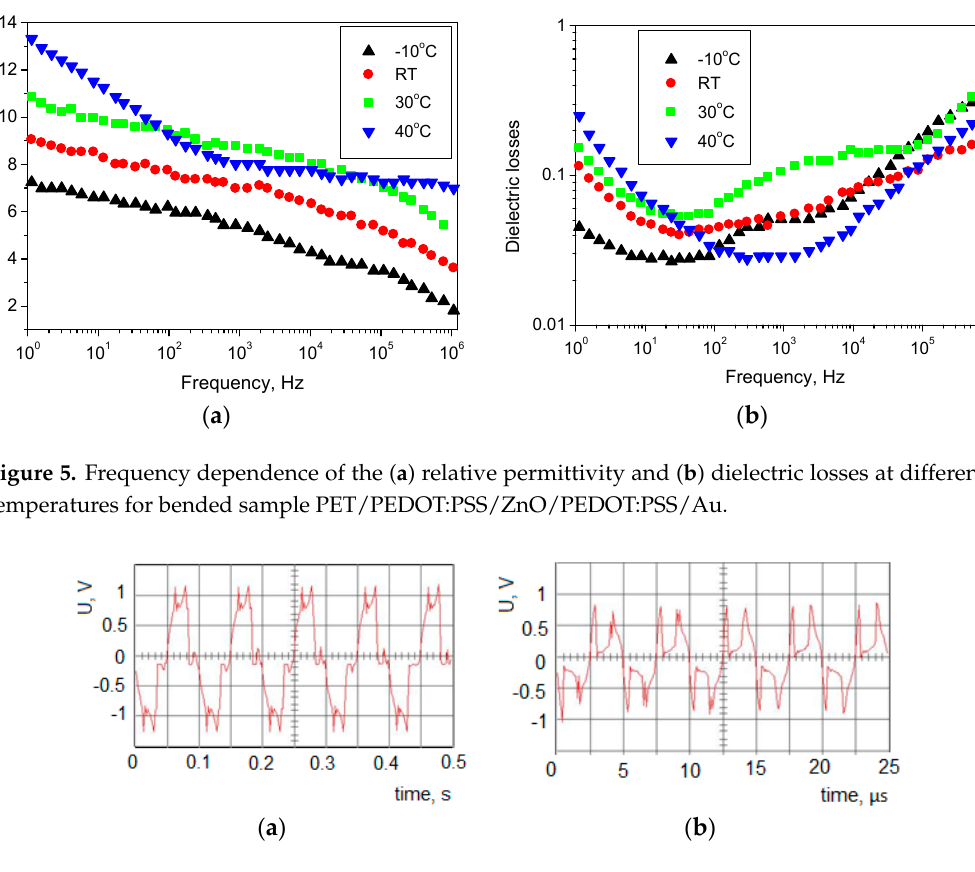
( b ) Figure 7. ( a ) Change of the current flow through the multilayer structure and the electrode sheet resistance as a function of the number of bends at a constant frequency of 10 Hz, and ( b ) relation between the voltage generated and the weight at static load.